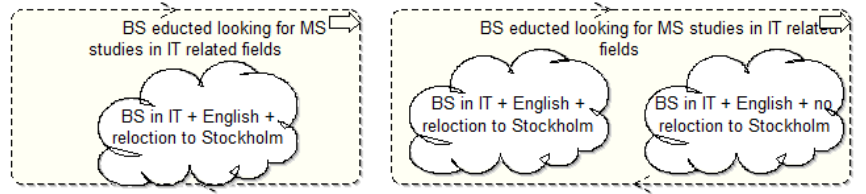
Figure 8. Extending the pool from which the students are drawn – from left to